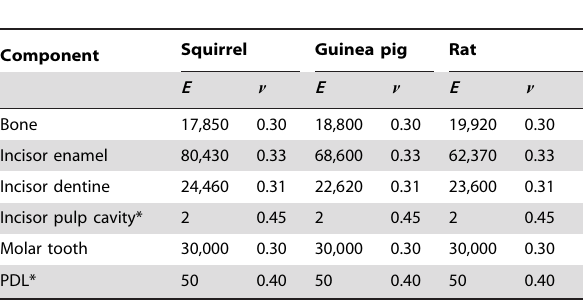
Table 3. Material properties of cranial and